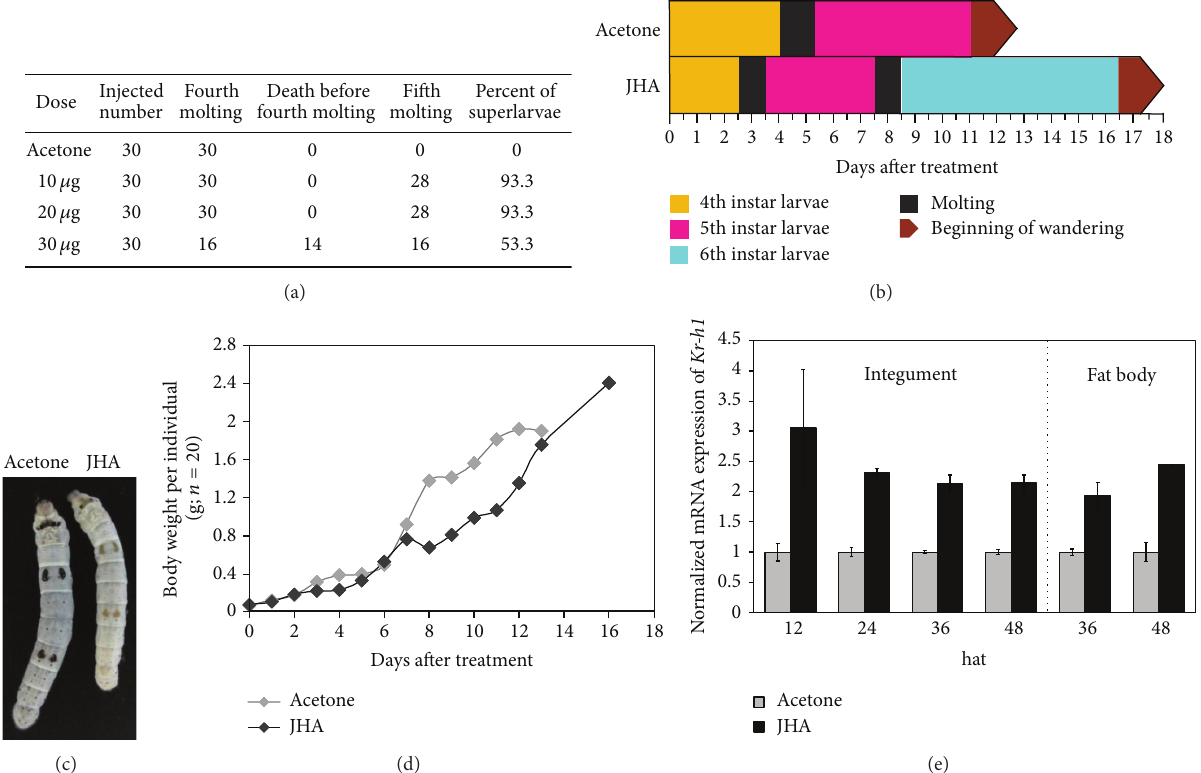
Figure 1: Induction of silkworm superlarvae by JHA application. Silkworm superlarvae were induced by applying the JH analogue (JHA) methoprene to newly molted silkworm larvae at the fourth instar. Silkworm larvae treated with pure acetone were used as a control. (a) Dose-dependent effects of JHA application on silkworm larval molting and survival. (b) JHA application at a dose of 20 𝜇 g per larva results in precocious larval molting and induces silkworm superlarvae. (c) Comparison of normal larva with pure acetone treatment (left) and larva with precocious onset of the fourth larval molting at 48 hours after JHA application. The developmental time point is at approximately 60–72 hours after treatment. (d) JHA application changes the body weight of silkworm larvae. (e) The mRNA expression of Kr-h1 , a JH-responsive gene, is increased after JHA application. Hat: hours after